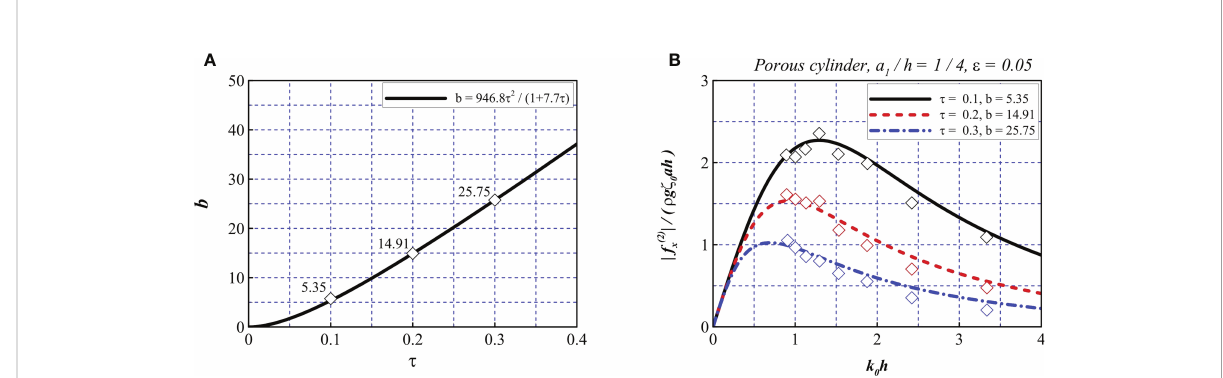
FIGURE 6 Determination of the non-dimensional parameter b . (A) The relationship between the non-dimensional porosity parameter b and the opening ratio t . (B) Validation of the numerical model (solid line) with experimental data